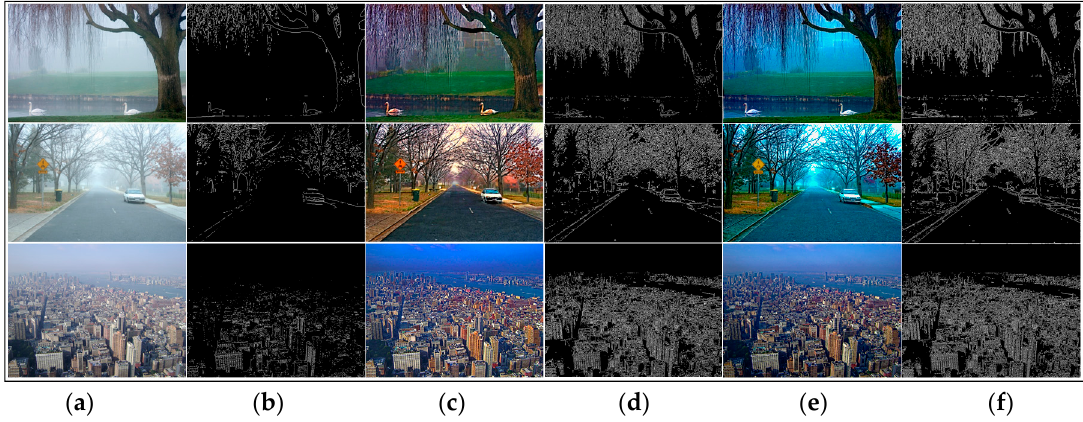
Figure 6. Comparison of our method to the method discussed by Tan [13] using real-world images. ( a , b ) are input hazy images and their corresponding visible edges, respectively; ( c – f ) are the dehazing results with corresponding visible edges generated by the method of Tan [13] and ours, respectively.